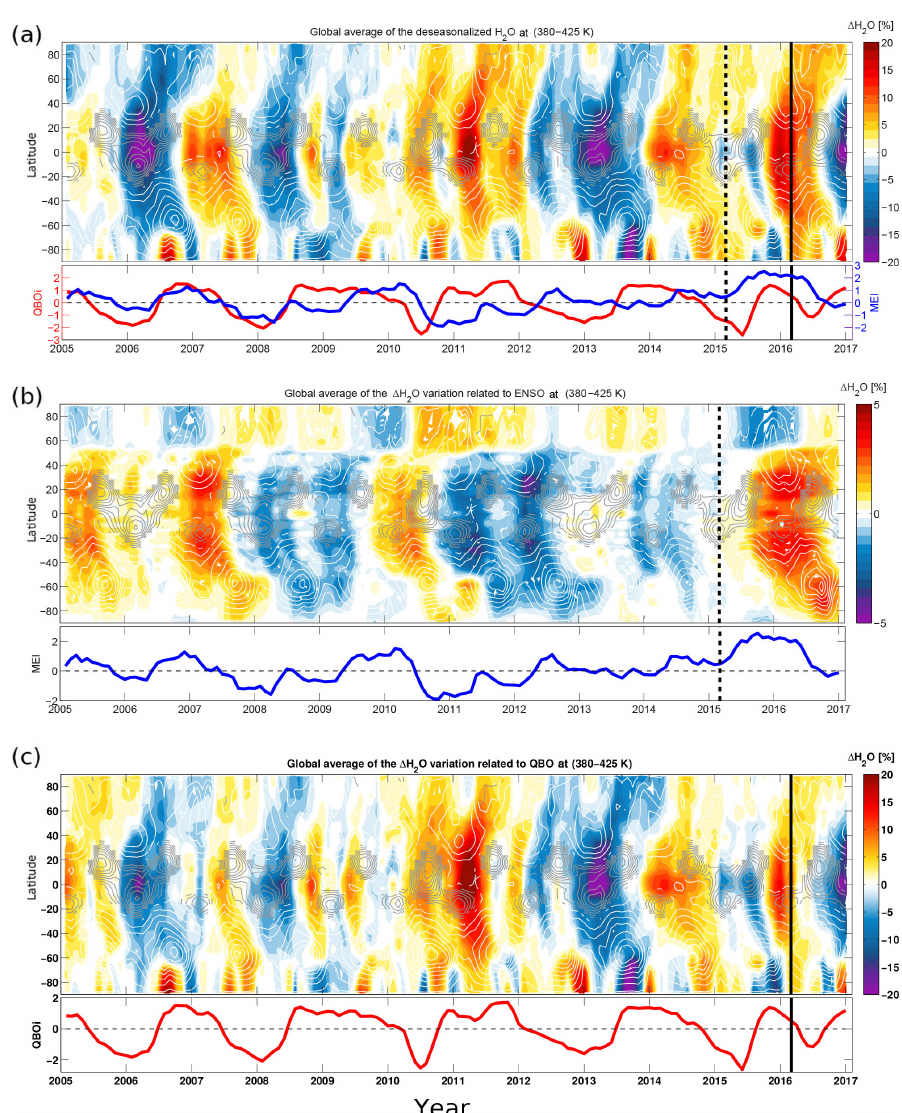
Figure 4. Latitude–time evolution of the global deseasonalized MLS H 2 O (a) together with the ENSO (b) and QBO (c) impact on lower stratospheric H 2 O in percent change from long-term zonal monthly means derived from the multiple regression fit and averaged between 380 and 425K for the 2005–2016 period. Note that there is a factor of 4 difference in the color scales in (b) and (c) reflecting the difference in the magnitude of the H 2 O changes related to ENSO compared to those related to the QBO. The vertical black dashed line indicates February 2015 for the warm ENSO onset. The vertical black line indicates February 2016 for the QBO shift onset. The monthly averaged zonal mean zonal wind component, u (ms − 1 ), from ERA-Interim between 380 and 500K is overlaid as solid white (westerly) and solid gray (easterly)